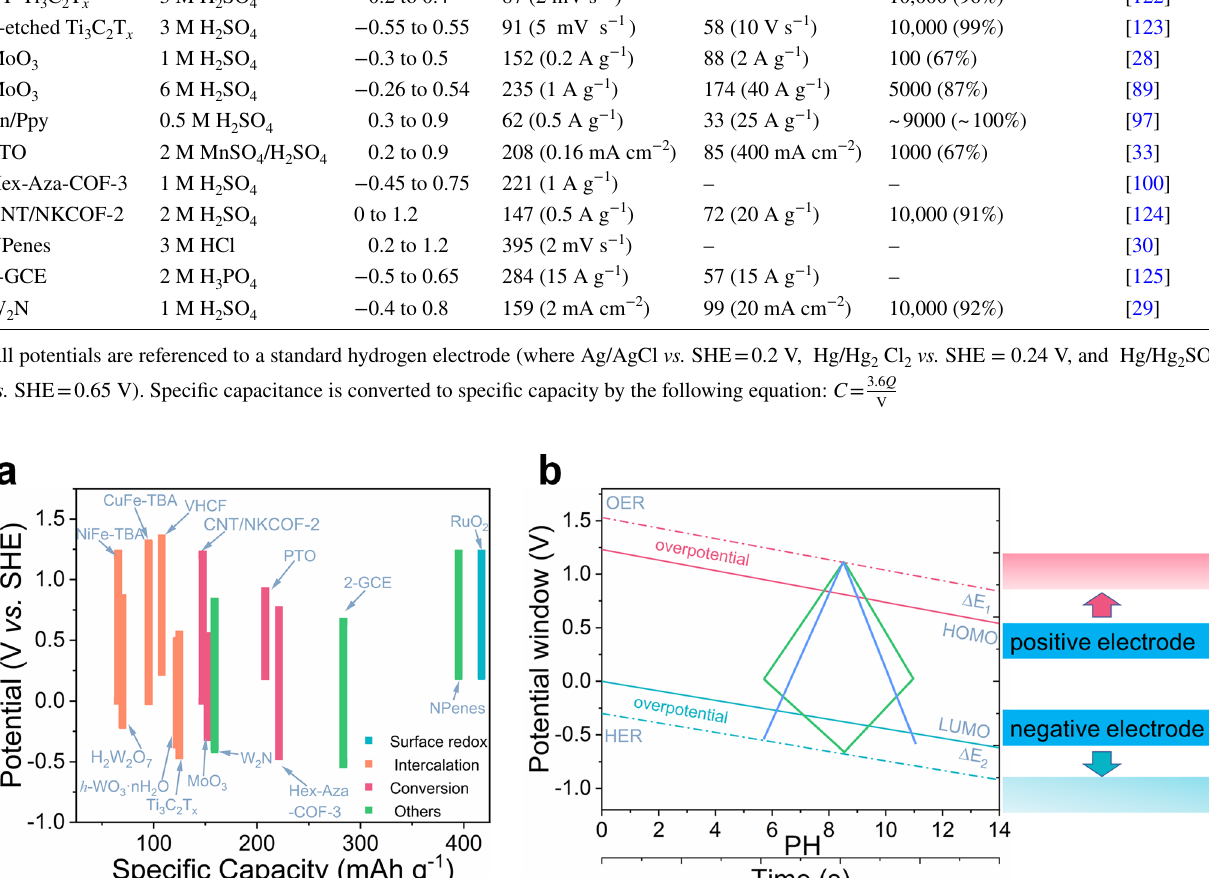
Fig. 9 a Summary of the potential window of various electrode materials for EPS. b Schematic of potential window of a water-based full cell at different